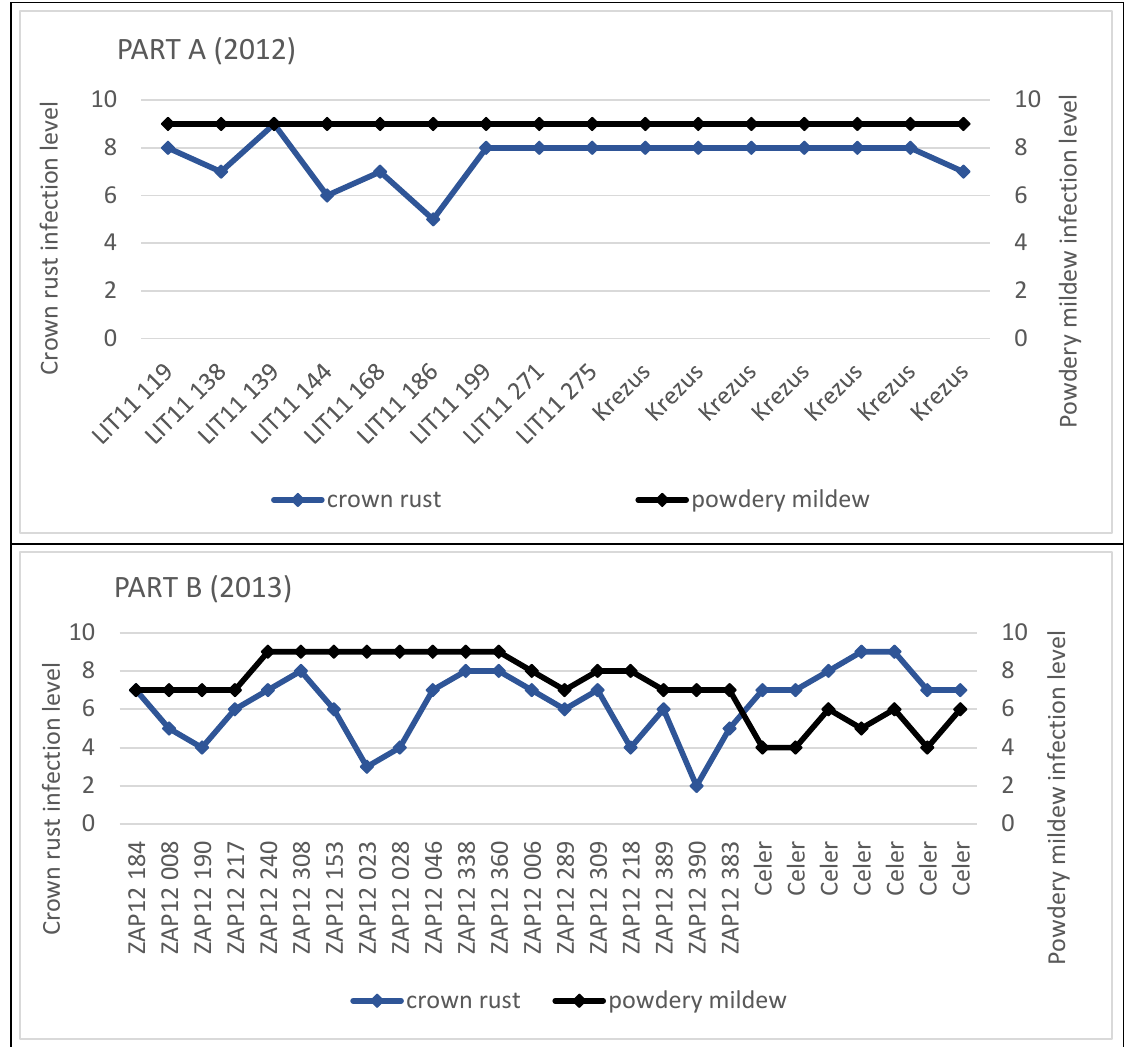
Figure 6. Resistance to powdery mildew and crown rust in cultivated Avena sativa L. gathered in Lithuania and evaluated in Poland in 2012 and 2013 (modified from Kloc and Dostatny, 2020) [27].